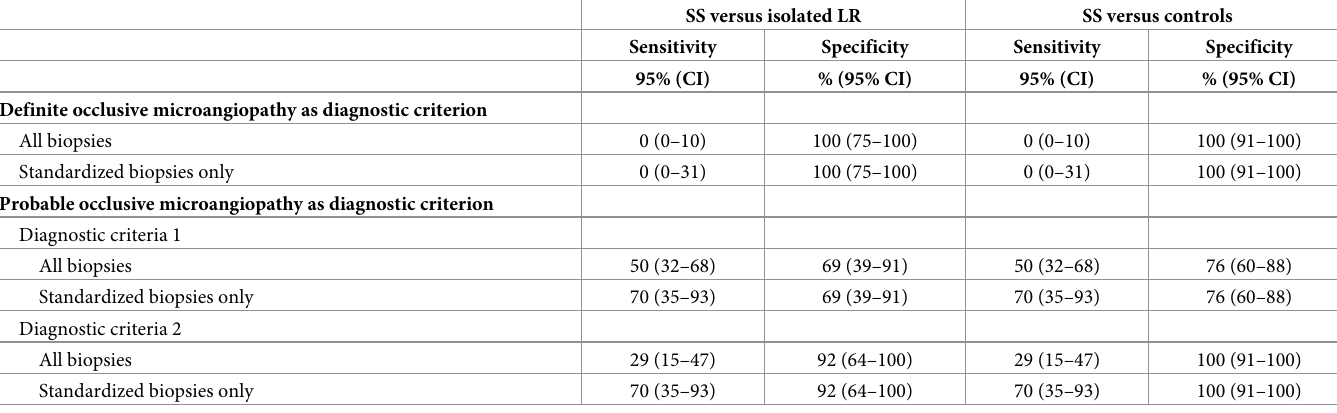
Table 3. Test characteristics of the skin